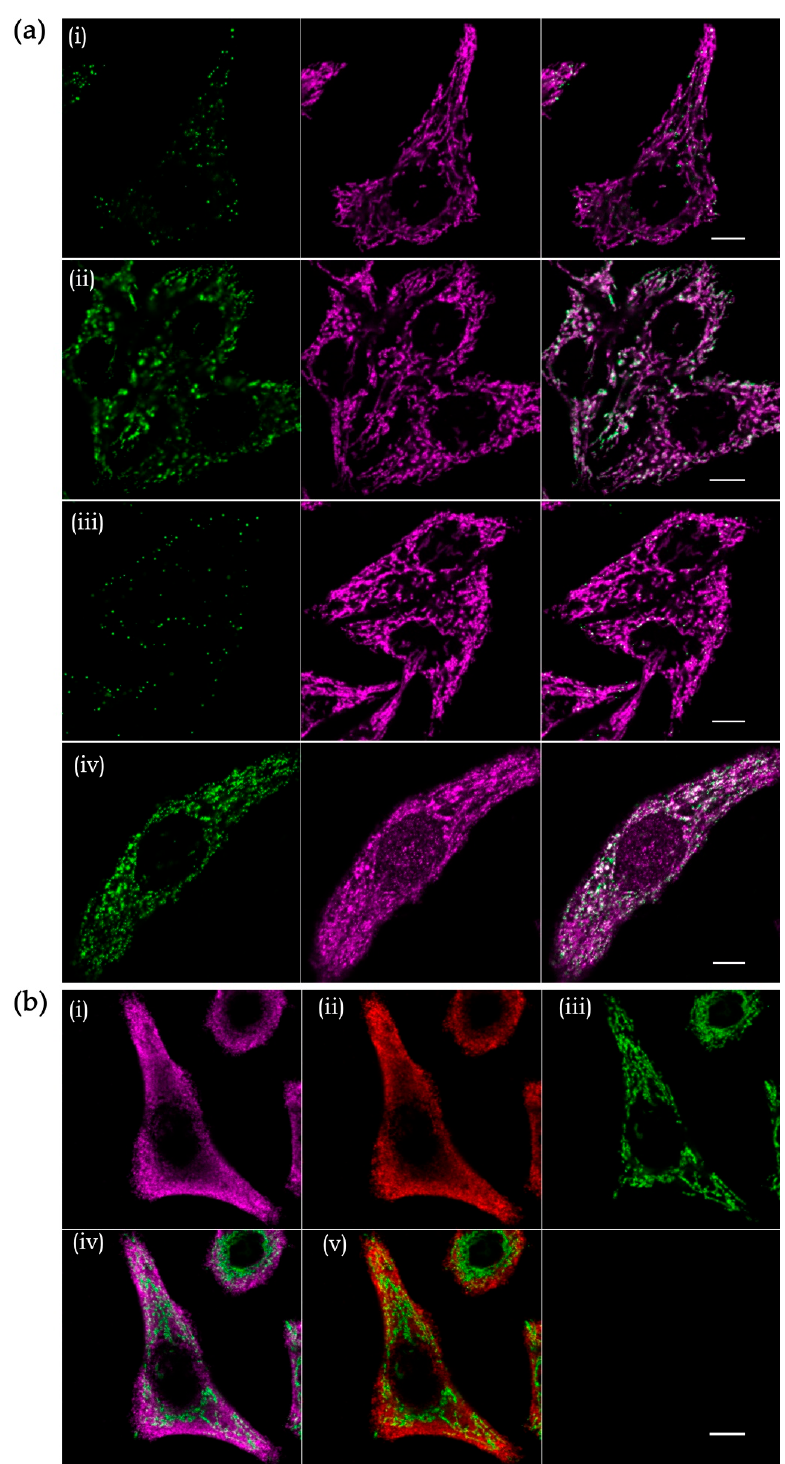
Figure 6. Detection of mitochondrial RNAs in HEK293T-Rex cells by RNA smFISH branched DNA and confocal microscopy. ( a ) mtDNA-derived transcripts: (i) MT-CYTB mRNA, (ii) 12S rRNA, (iii) mirror-12S rRNA, and (iv) tRNA Val . RNAs are shown in green (left column), and mitochondria stained with antibodies to TOM20 (i–iii) or mL38 (iv) are in magenta (middle column). The right column shows merged images. ( b ) Nuclear-encoded transcripts: (i) 5S rRNA and (ii) 5.8S rRNA. Panel (iii) shows TOM20. Panels (iv) and (v) are merged images for 5S rRNA/TOM20 and 5.8S rRNA/TOM20, respectively. Scale bars are 10 µ